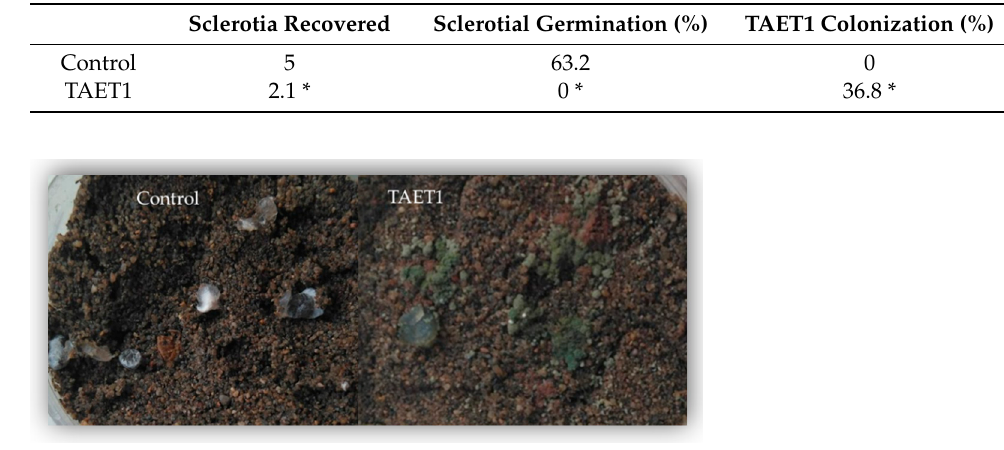
Figure 5. Effect of TAET1 on sclerotial germination. Control: sclerotia with white mycelium on their surface. TAET1: Observation of Trichoderma on soil surface (green mass).